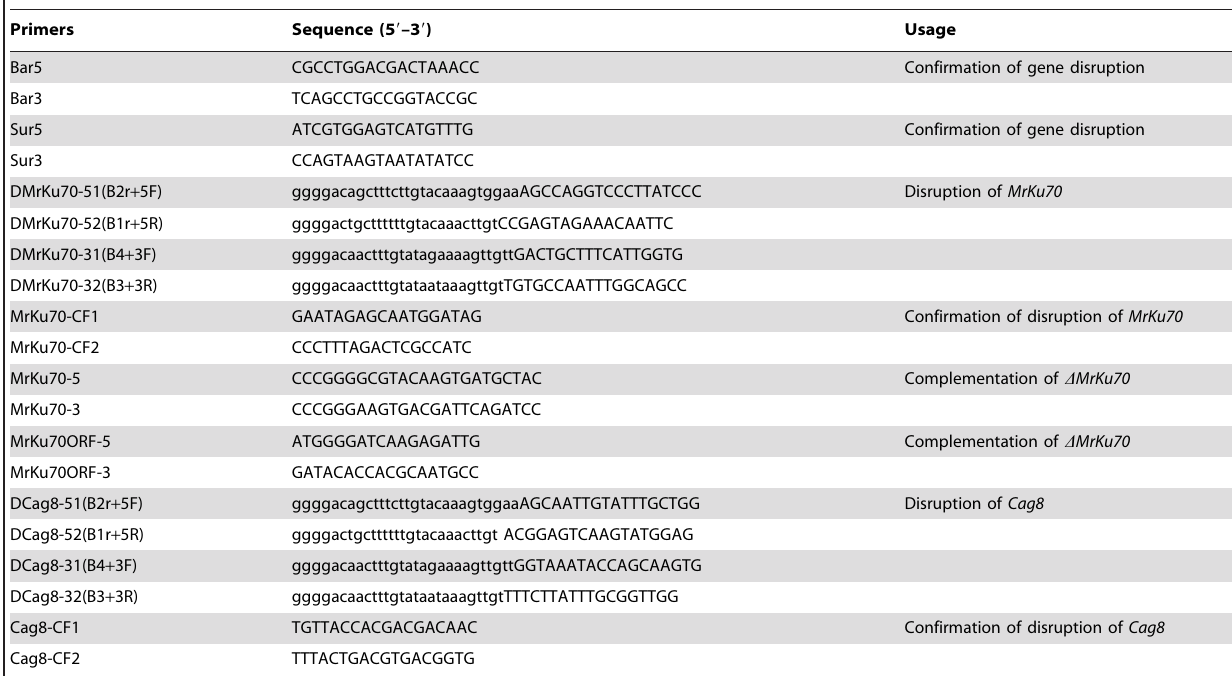
Table 1. Primers used in this